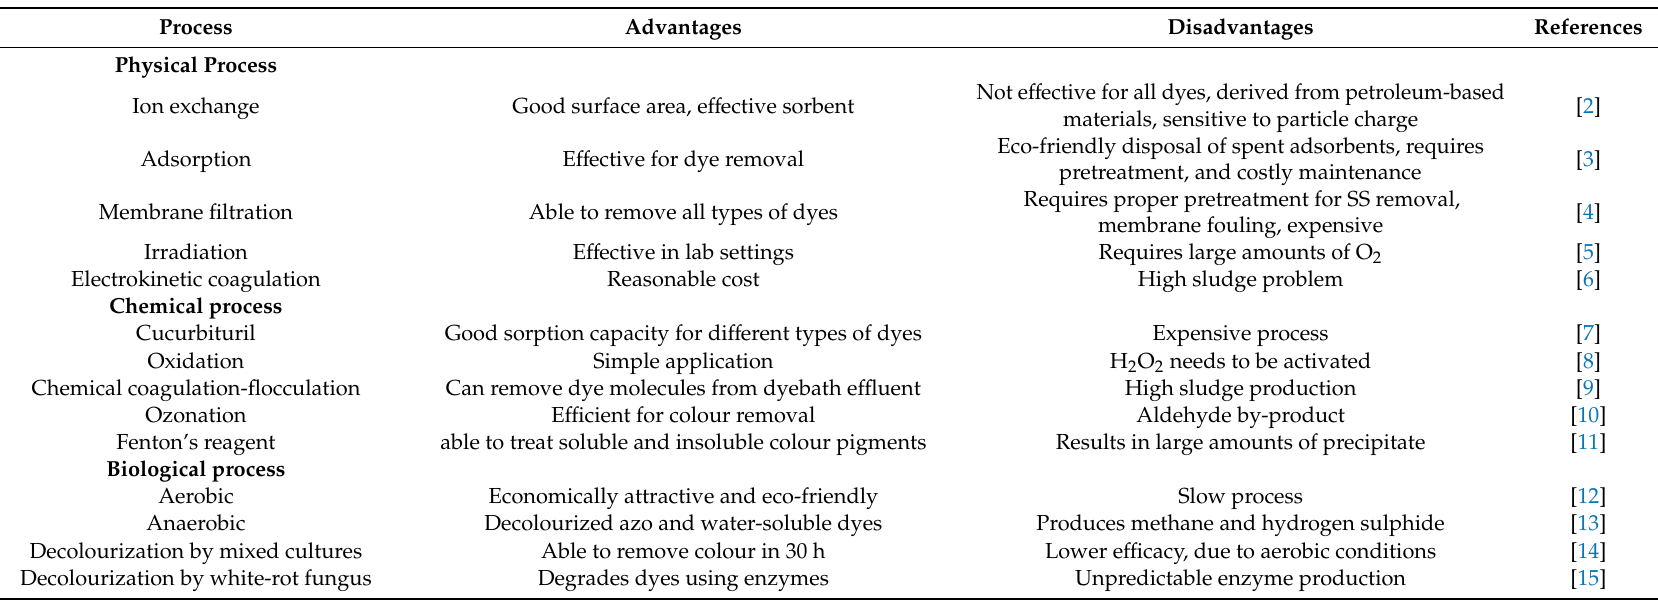
Table 1. Advantages and disadvantages of the physical, chemical, and biological processes in dye wastewater